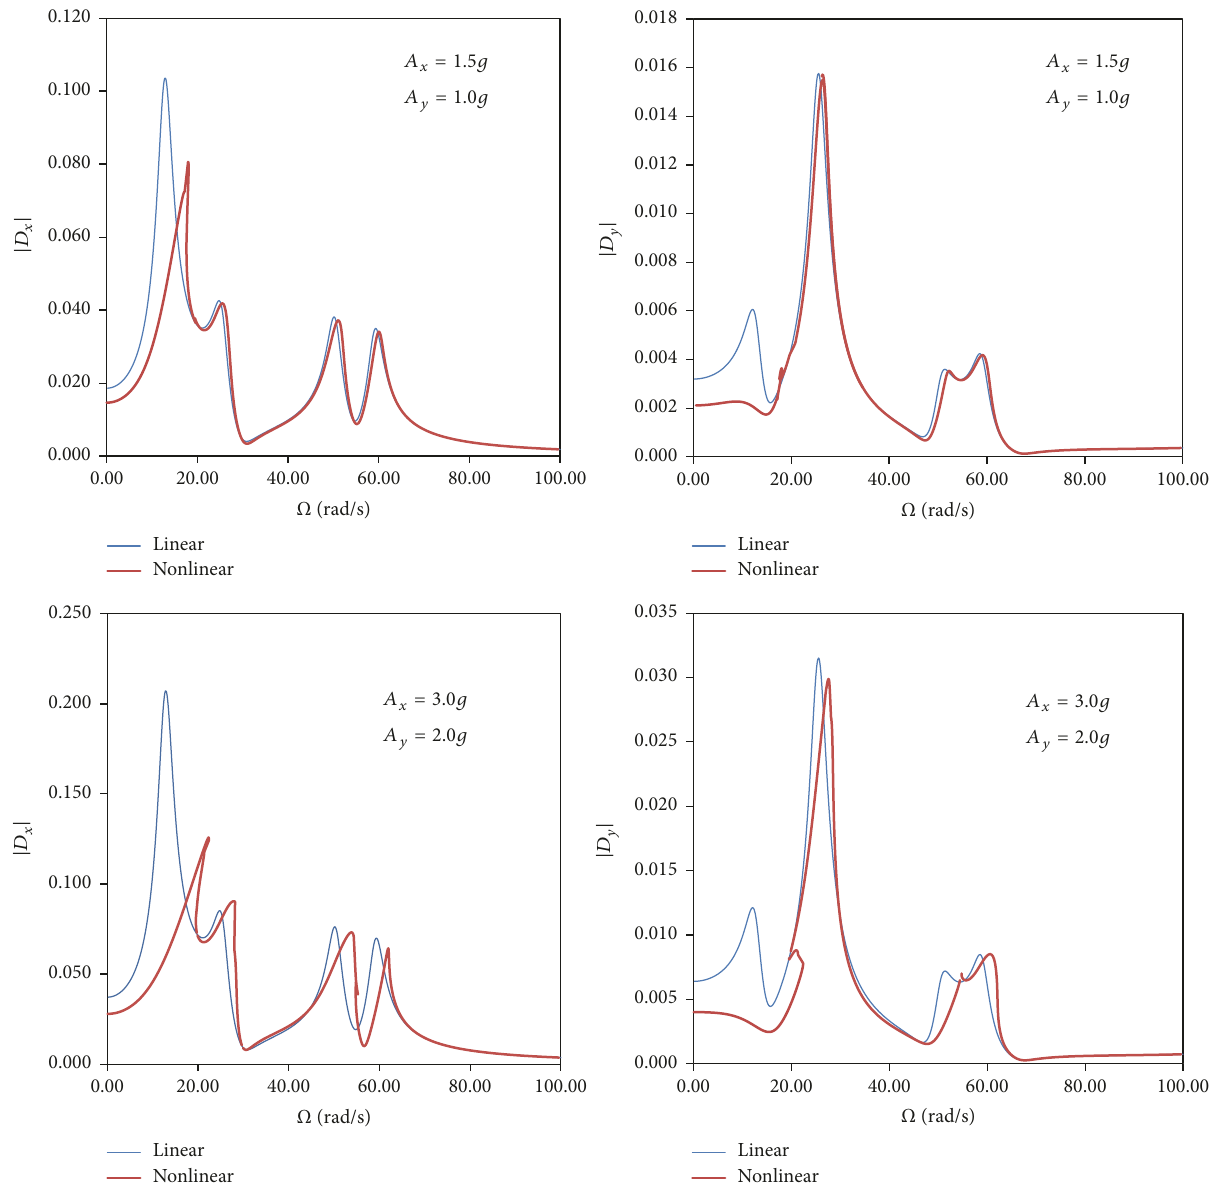
Figure 17: Horizontal and vertical displacements at the top of the frame as a function of the forcing frequency due to simultaneous horizontal and vertical forcing. 𝐿 = 16 m and 𝐻 = 6